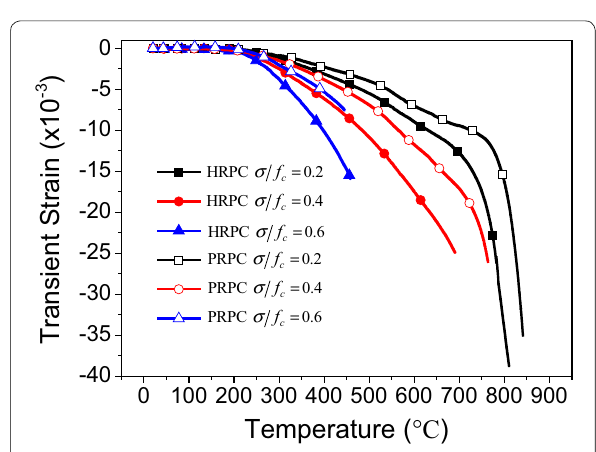
Fig. 14 Comparison between TS of HRPC and